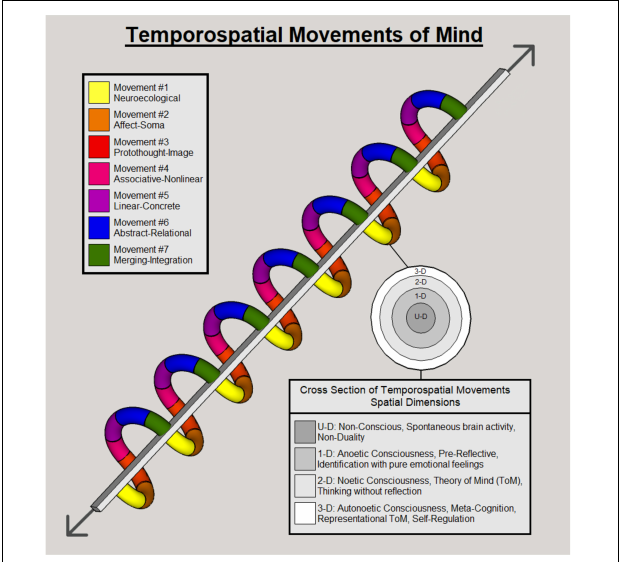
FIGURE 1 | This is a visual representation of the temporospatial model to refer throughout the paper. It is followed by sections describing each spatial dimension and temporal movement in depth. For further clarification, each ring composes a full temporospatial cycle. The end (Merger-Integration) is reconsolidated into the beginning (Neuroecological), as the beginning builds upon the end (where green and yellow meet). They are iterative in nature, and can move in either direction (i.e., regression, progression). Temporal cycles are coded to corresponding colors, a cross section of which reveals their volumetric composition as spatial dimensions. Spatial dimensions are illustrated as rings to a tree trunk, colored in light gray. Note that spatial volume and temporal movements form a single stream, and each phase within respective cycles are nested within one another. Artwork by Daniel